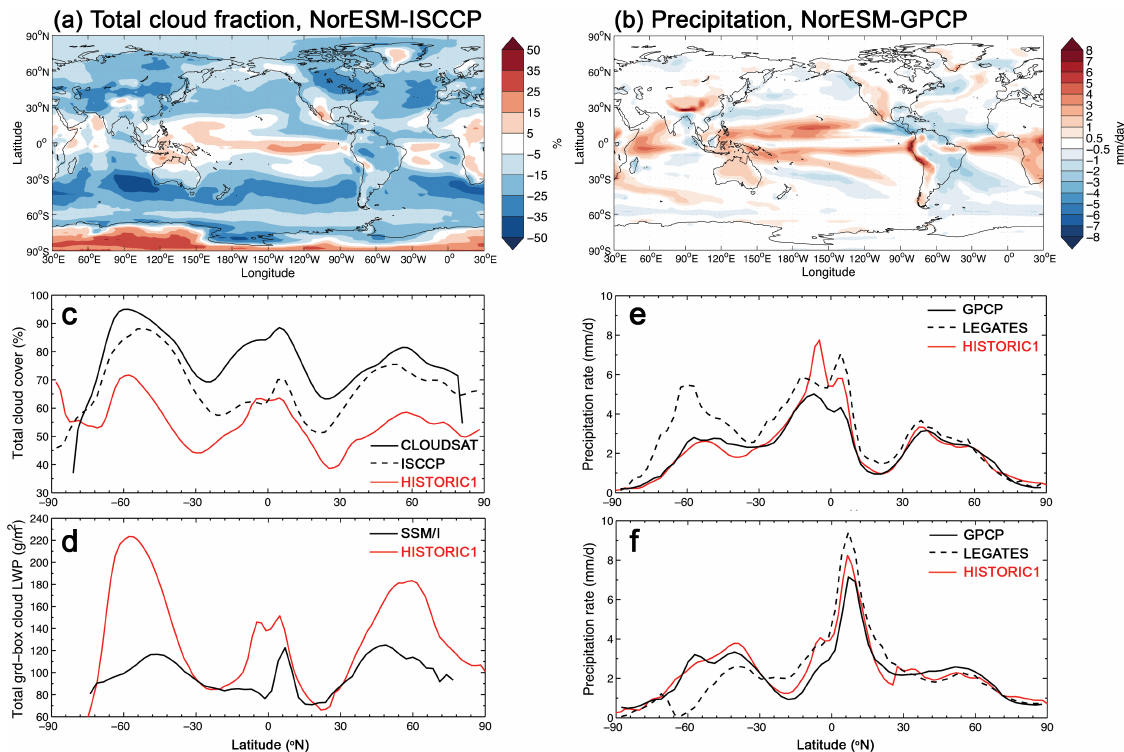
Fig. 7. (a) Difference in total cloud fraction (%) between NorESM and the ISCCP D2-retrievals 1983–2001 (Rossow and Schiffer, 1999; Rossow and Due˜nas, 2004). (b) Difference in estimated annual precipitation between NorESM and the Global Precipitation Climatology Project (GPCP) observationally based data set (Adler et al., 2003; Huffman et al., 2009). (c) Zonally averaged total cloud fraction (%) of NorESM compared to ISCCP D2-retrievals 1983–2001 and Cloudsat radar and lidar retrievals from September 2006–November 2008 (L’Ecuyer et al., 2008). (d) Zonally averaged total liquid water path (g m − 2 ) of NorESM compared to SSM/I retrievals over oceans for the period 1987–2000 (e.g. Wentz, 1997; O’Dell et al., 2008). (e) Zonally averaged boreal winter (DJF) estimated annual precipitation of NorESM compared to the data from GPCP and Legates (Spencer, 1993; Legates and Willmott, 1990), and (f) the same for boreal summer (JJA). NorESM variables are means for the years 1976–2005 of the Historical1